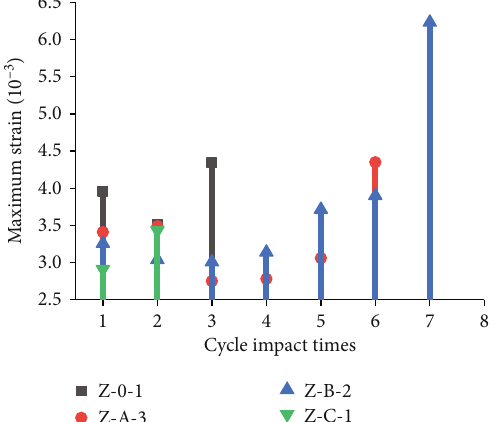
Figure 8: Relationship between the maximum strain and cycle impact times.